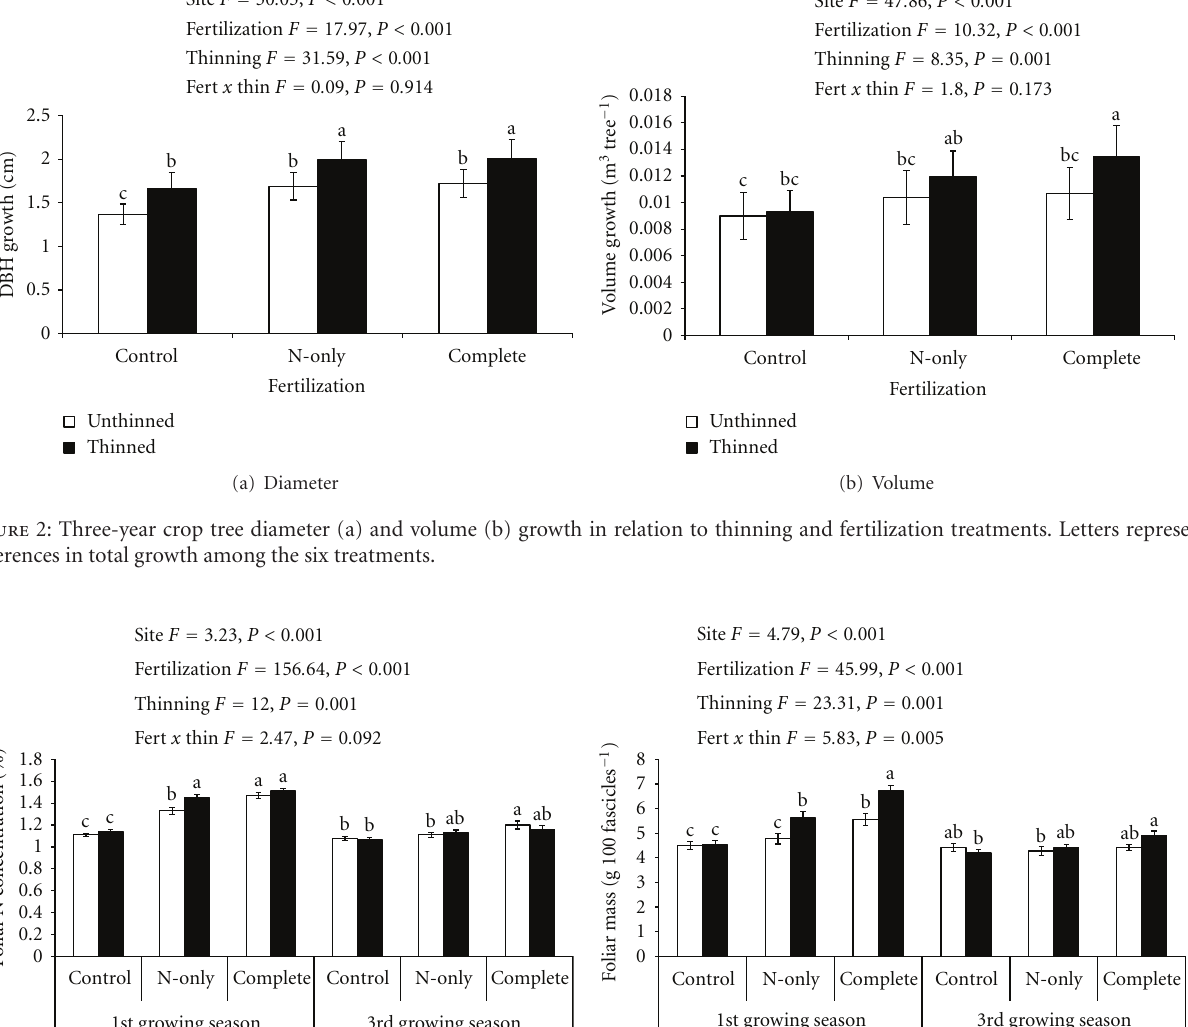
but SO 4 concentration decreased with N-only